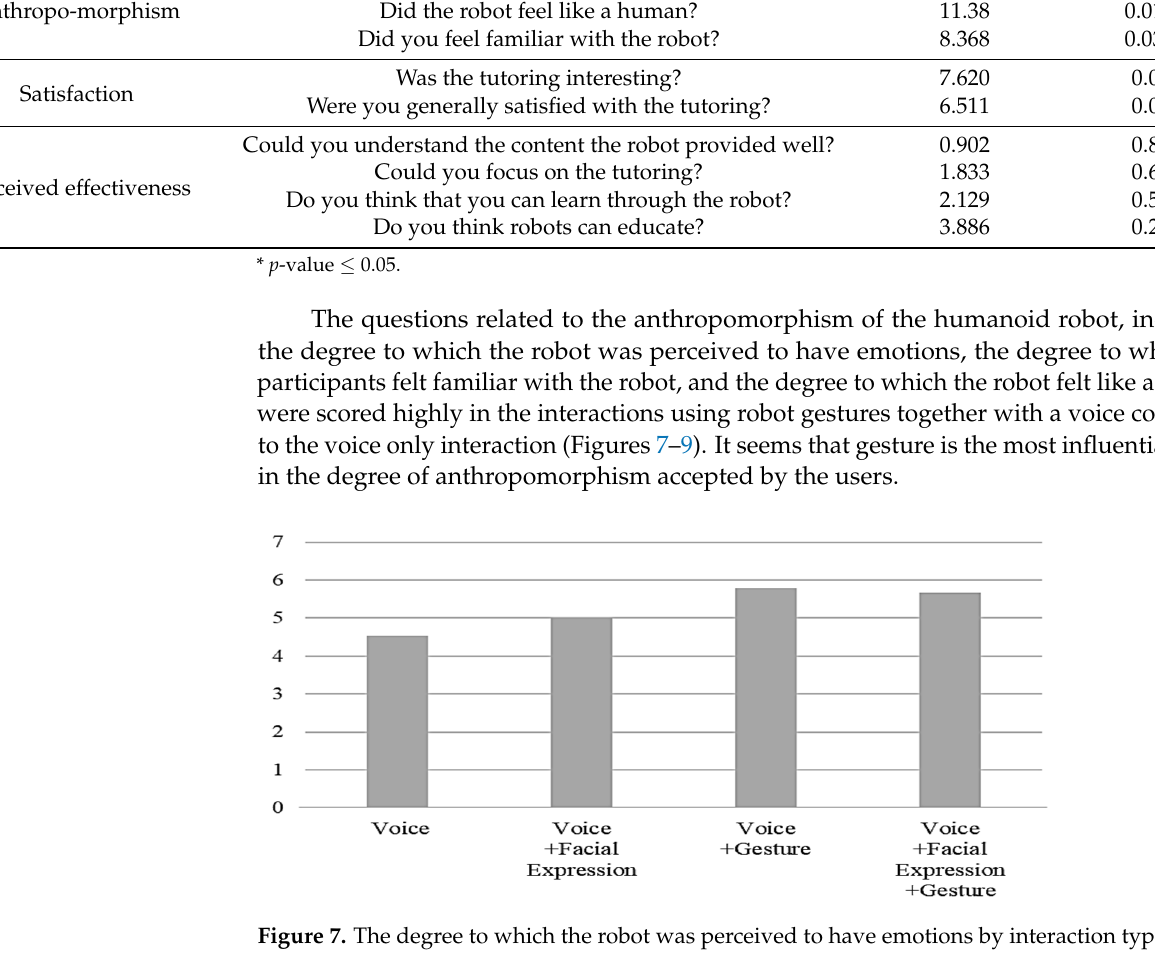
Figure 9. Degree to which the participants felt familiar with the robot by interaction type. 4.3. Task Performance according to the Interaction Type The subjective evaluation consisted of an assessment of the degree of anthropomor- phism. Similar to the subjective evaluation, the measured task performance did not follow a normal distribution, so non-parametric tests were conducted to determine whether there was a difference in the number of touch errors and retrainings, as well as whether the training was successful, according to the interaction method. The analysis was performed based on the data from a total of 14 participants. The results showed that there were no significant differences in any of the quantitatively measured indicators related to perfor- mance. Detailed descriptions of each measurement are described in the following sections.